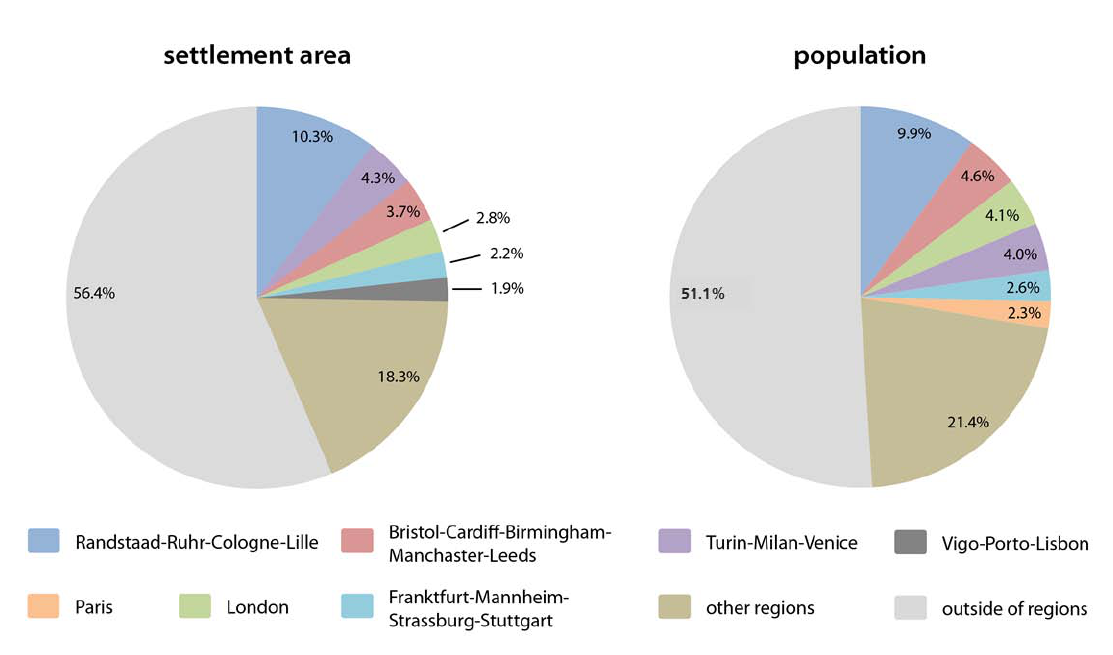
Figure 6. Plausibilization of delimited regions by comparison to their population